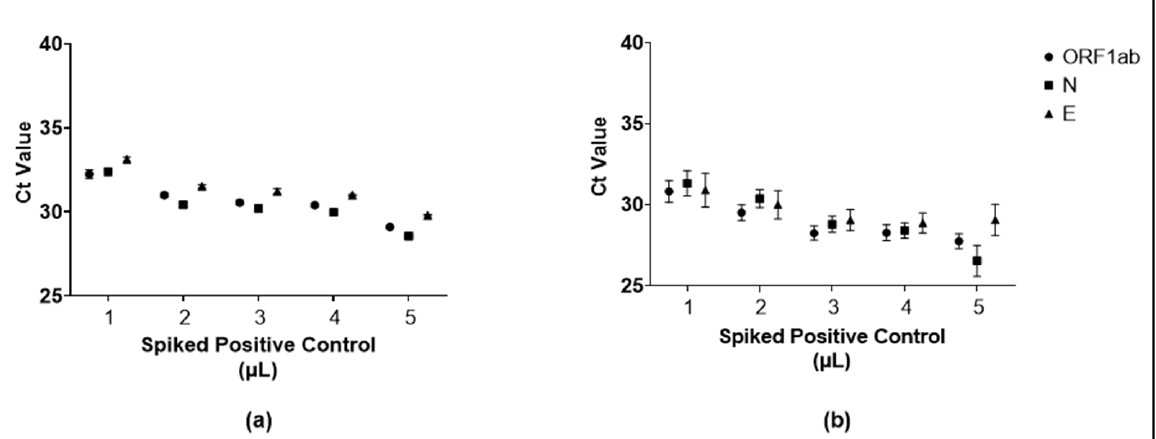
Figure 3. Ct value of the negative specimens with positive control spike-in. The difference in the resulting Ct value of ORF1ab, N, and E genes at each point of 1–5 μ L spike-in of fresh saliva specimens ( a ) and stored saliva specimens ( b ). Results were interpreted by mean ± SD from triplicate testing.